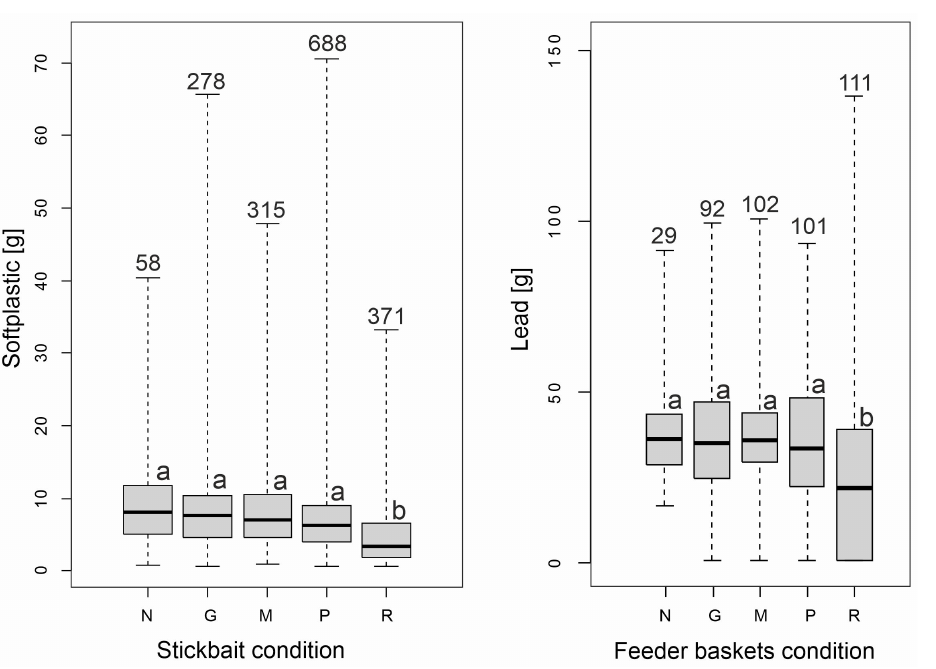
Figure 5. Box–whisker plot (25% quantile, median. 75% quantile, whisker: minimum and maximum values) of the weight proportion of soft plastic (g) in stickbaits and lead (g) in feeder baskets attributed to five different conditions. N = new, G = good condition, M = medium condition, P = poor condition, and R = largely rotten item. Letters above the median indicate significant differences between items. Numbers above the whisker indicate the number of items in the respective group.